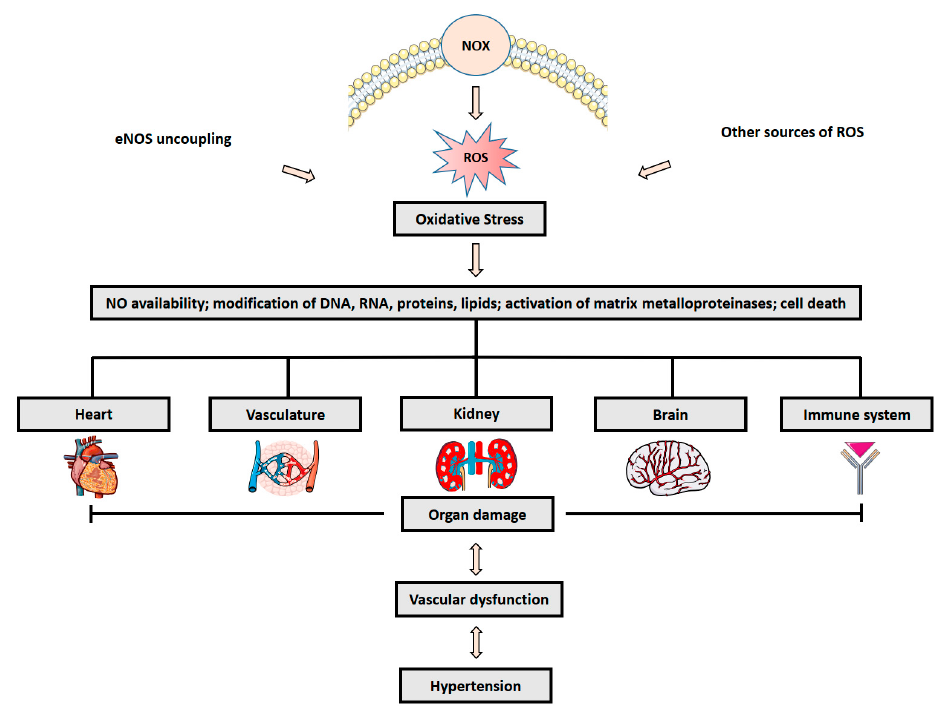
Figure 3. ROS formation and hypertension. Activation of NADPH oxidases (NOX) and other sources of reactive oxygen species (ROS) promotes oxidative stress, and leads to organ damage, vascular dysfunction and hypertension. Parts of figure are adapted from SMART—Servier Medical Art, Servier: https://smart.servier.com. https://creativecommons.org/licenses/by/3.0/ (accessed on 22 September 2022).